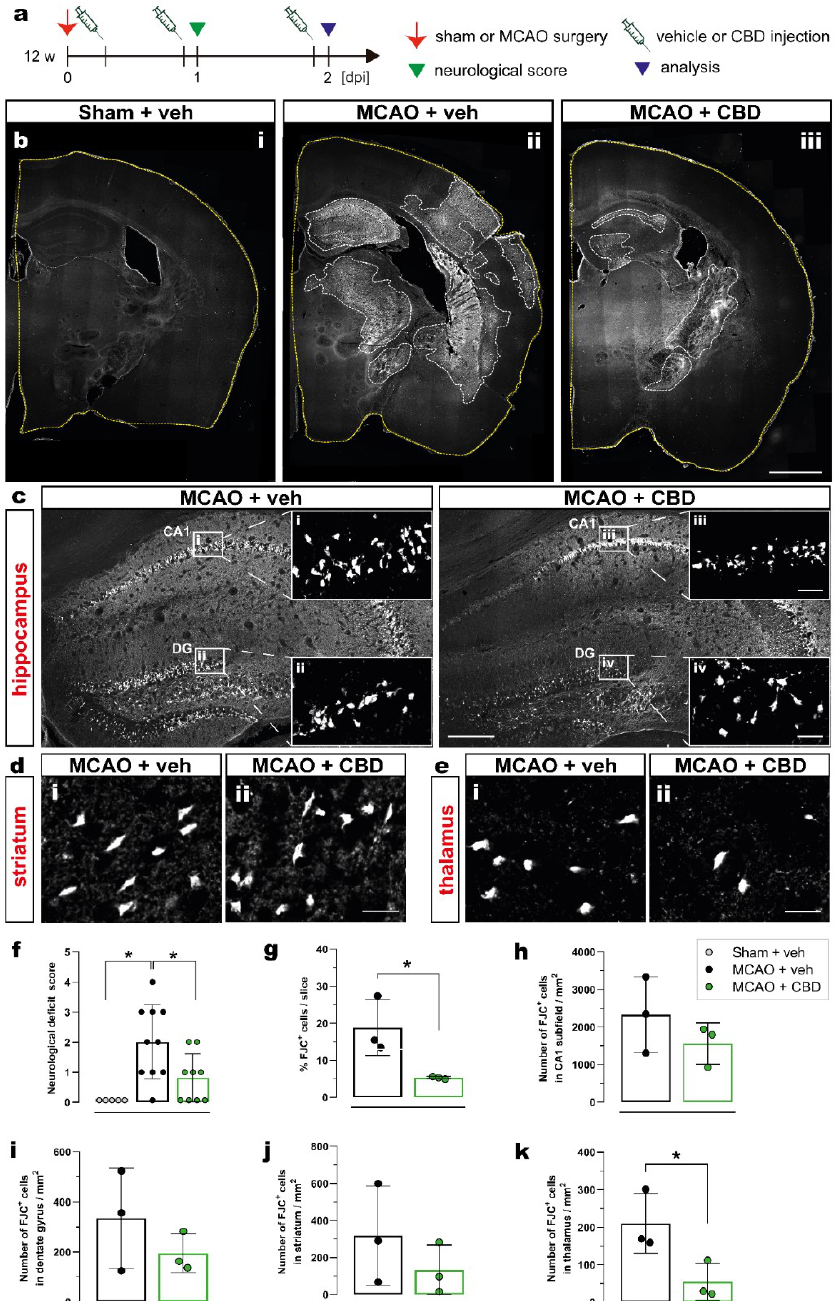
Figure 1. Reduction in ischemia-induced neurodegeneration and neurological deficits after CBD treat- ment. ( a ) Experimental design: C57BL/6N WT mice were submitted to sham or MCAO surgery and were injected with vehicle or CBD. One day after reperfusion the neurological score was